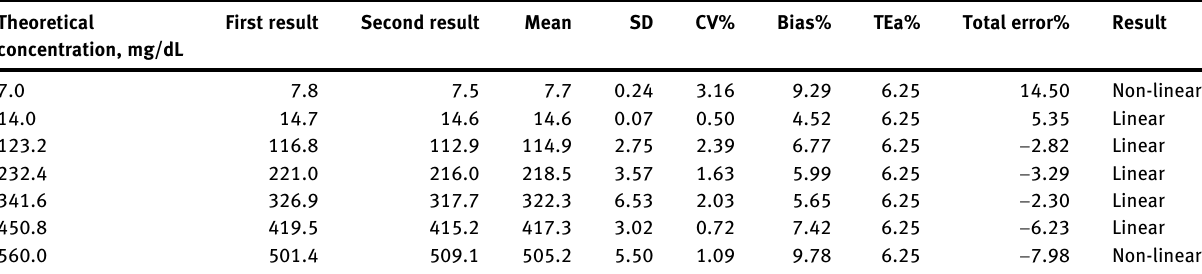
Table  : Enzymatic method linearity results.